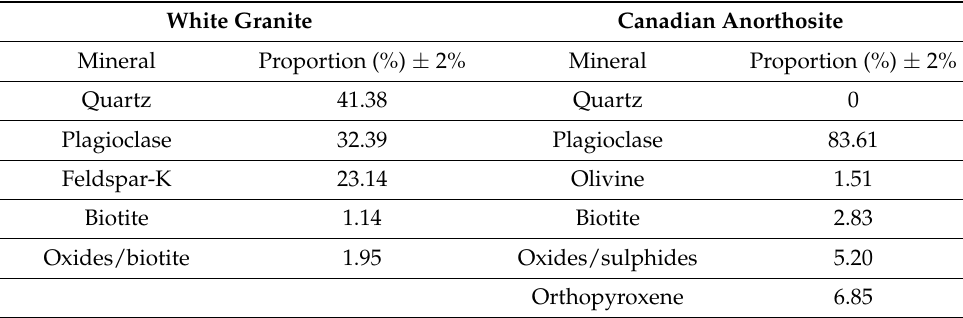
Figure A2. Black granite (Canadian anorthosite): scattered electrons image (OIS Service Géoscientifiques Inc., Chicoutimi, QC, Canada). Table A1 compares the minerals present in the two granites and their proportions. Table A1. Mineral distribution in white granite and Canadian anorthosite.